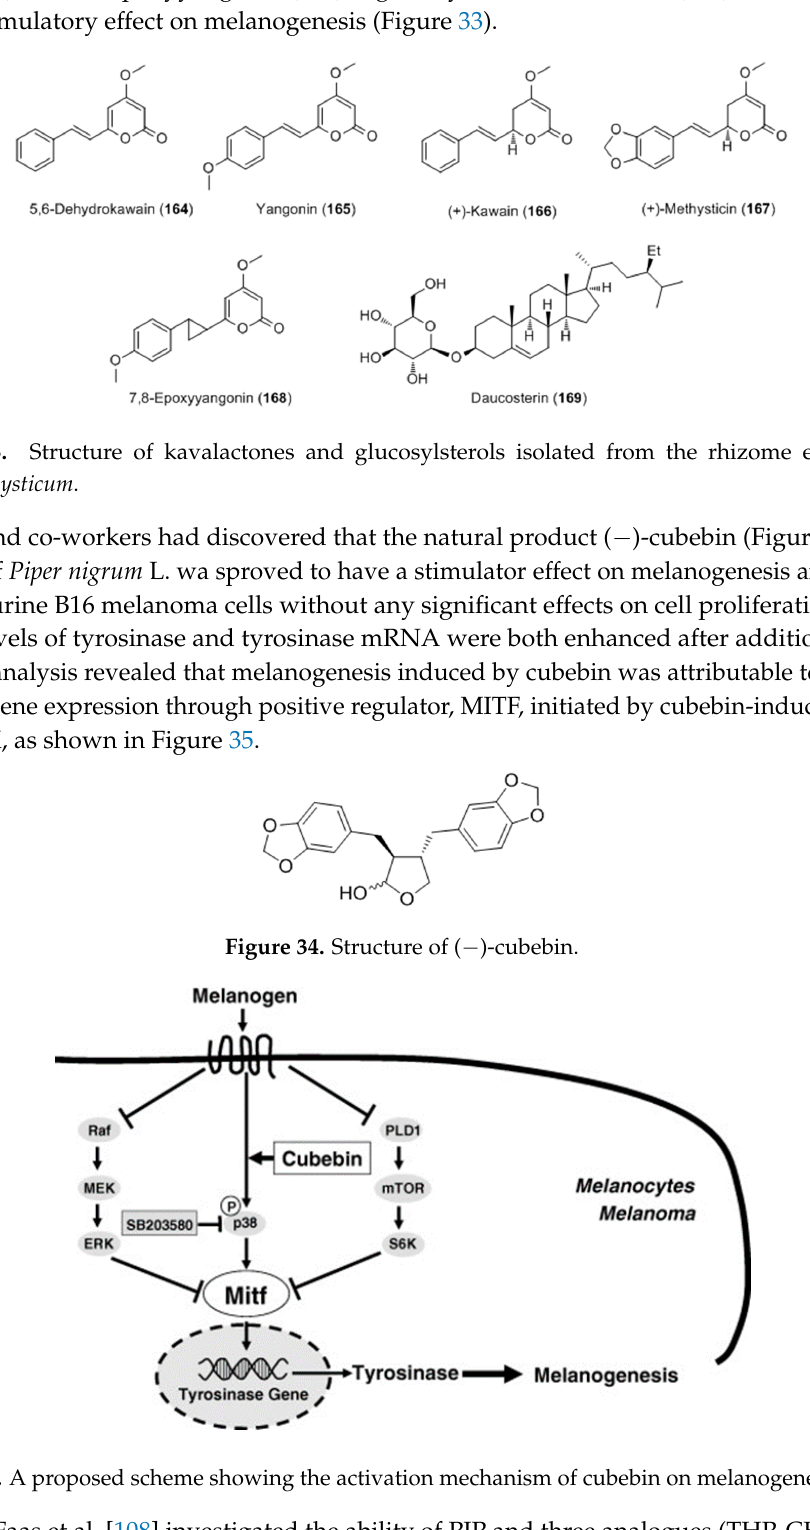
Figure 32. Structure of epigallocatechin-3-gallate.